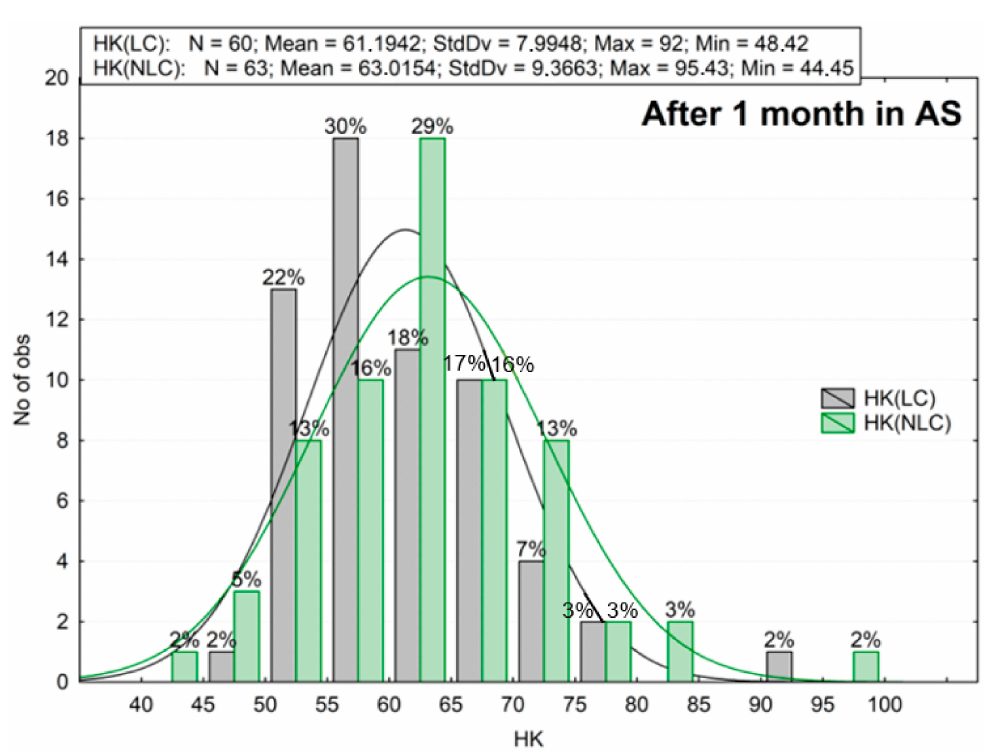
Figure 4. The results of Knoop hardness measurements for B-F after aging in artificial saliva (AS) for one month. LC—light-cured surface of sample (the top side of a sample), NLC—non-light-cured surface (the bottom side of a sample), HK—Knoop